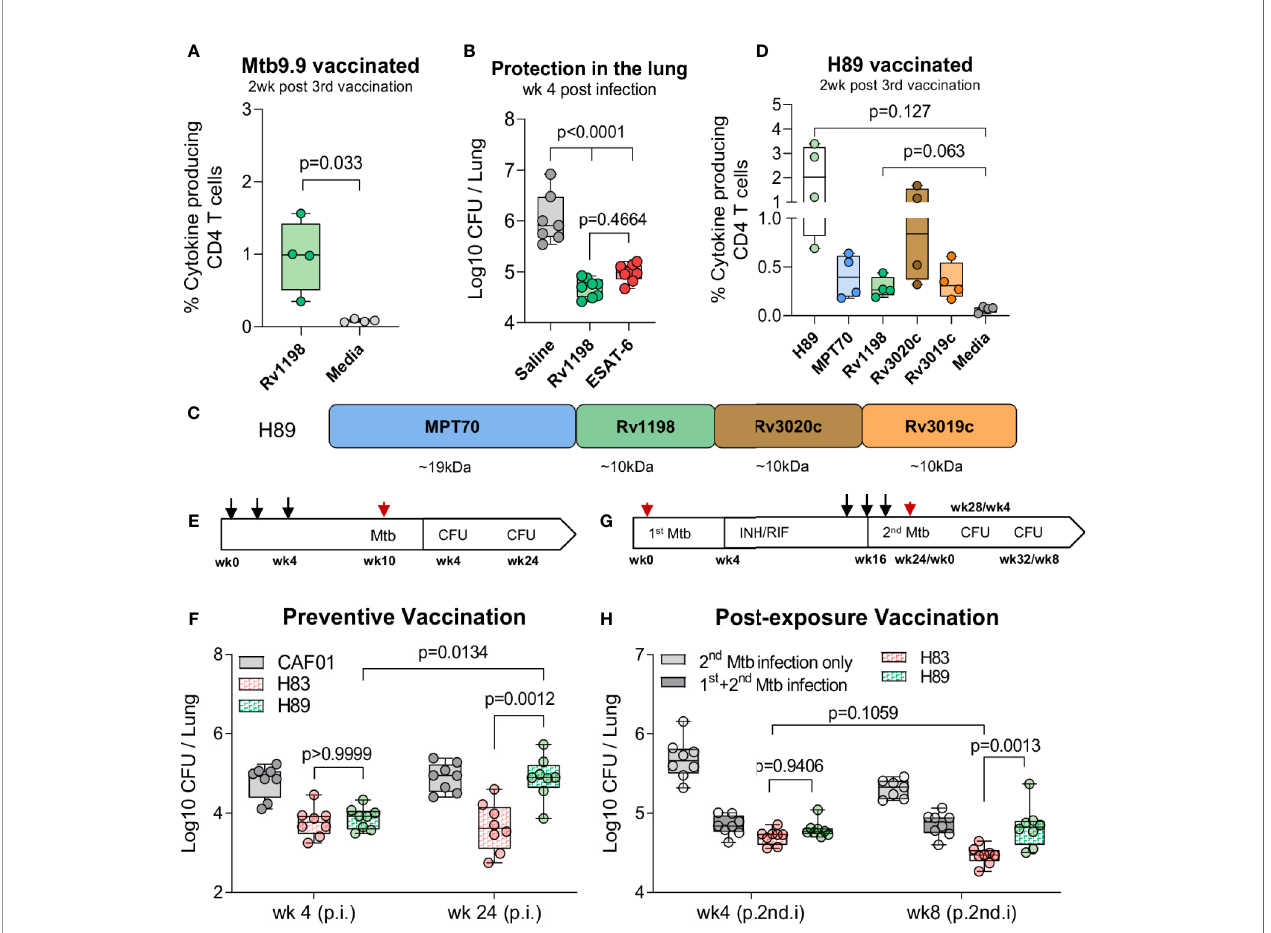
FIGURE 3 | H83, but not H89, mediate long-term protection in chronically infected mice. (A) Percentage of of Rv1198-speci fi c CD4 T cells was assessed in Mtb9.9-vaccinated CB6F1 mice by ICS. Splenocytes were restimulated Rv1198 pepmix or media two weeks post 3 rd vaccination (n = 4). Paired t-test, two-tailed, t- values (3.75, df = 3). (B) The bacterial burden were determined in the lungs of saline, Rv1198 and ESAT-6-vaccinated mice 4 weeks post Mtb infection (n = 8) as shown by CFUs relative to mice immunized with saline. An Ordinary One-way ANOVA with Tukey ’ s multiple comparison test, F-value (5, 41) = 41.59, was performed and the exact p-values indicated. (C) H89 was constructed by replacing ESAT-6 with an ESAT-6 like antigen, Rv1198, in a vaccine consisting of the same highly immunogenic antigens as in H83. (D) Percentage of antigen-speci fi c CD4 T cells in H89-vaccinated mice. Splenocytes were restimulated with H89, MPT70, Rv1198, Rv3020c, Rv3019c, or media two weeks after 3 rd vaccination (n = 4). Brown-Forsythe and Welch ANOVA tests with Dunnett ’ s multiple comparison test, F-value (3.000, 3.045) = 8.660, W-value (3.000, 5.882) = 7.711. (E) Schematic overview of the standard preventive model. Mice were vaccinated s.c. three times with the CAF01 adjuvant only or 0.5 µg H83 or H89 at the base of the tail with two-week interval (black arrows) and challenged with 50 – 100 CFU Mtb Erdman 6 weeks after the 3 rd vaccination (red arrow). CFUs were determined 4 and 24 weeks after Mtb challenge. (F) Early (week 4) and late chronic (week 24) vaccine protection of H83 and H89 in a preventive setting (n = 8). A Two-Way ANOVA with Tukey ’ s multiple comparison test comparing cell means regardless of rows and columns, F interaction (3, 56) = 3.134, F row (1, 56) = 6.819, F column (3, 56) = 12.77. Post infection (p.i.) (G) Schematic overview of the re-infection model (post-exposure vaccination). CB6F1 mice were infected by the aerosol route with 25-50 CFU Mtb Erdman (1 st infection, red arrow). One group of mice were left uninfected. Four weeks into the infection mice were administered antibiotics in their drinking water for 12 weeks to clear the primary infection. At week 14, 16, and 18, mice were immunized with 0.5 µg H83 or H89 s.c. at the base of the tail or left non-vaccinated (black arrows). All mice were then challenged with 50 – 100 CFU Mtb Erdman (2 nd infection, red arrow) 6 weeks post 3 rd vaccination and level of lung infection was quanti fi ed 4 and 8 weeks into 2 nd Mtb infection. (H) In the reinfection model: Total lung CFU in non-vaccinated mice (2 nd infection only), Mtb memory mice (1 st & 2 nd infection), H83 and H89-vaccinated mice 4 and 8 weeks after the 2 nd Mtb infection (n = 8). Post 2 nd infection = (p.2 nd .i). A Two-Way ANOVA with Tukey ’ s multiple comparison test comparing cell means regardless of rows and columns, F interaction (3, 55) = 5.503, F row (1, 55) = 11.48, F column (3, 55) = 85.10. Exact p-values are indicated. Data shows box plots with whiskers indicating minimum and maximum